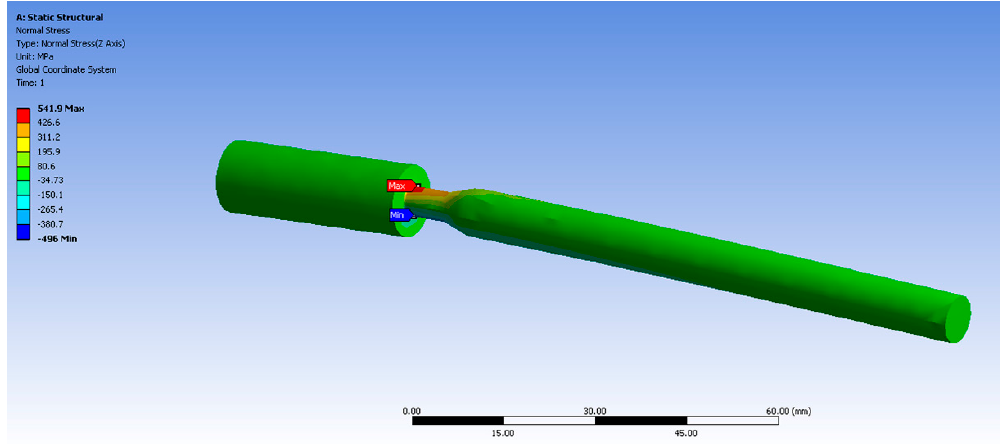
Figure 2. Normal stress (MPa) on the fatigue sample for a load of 50 N.